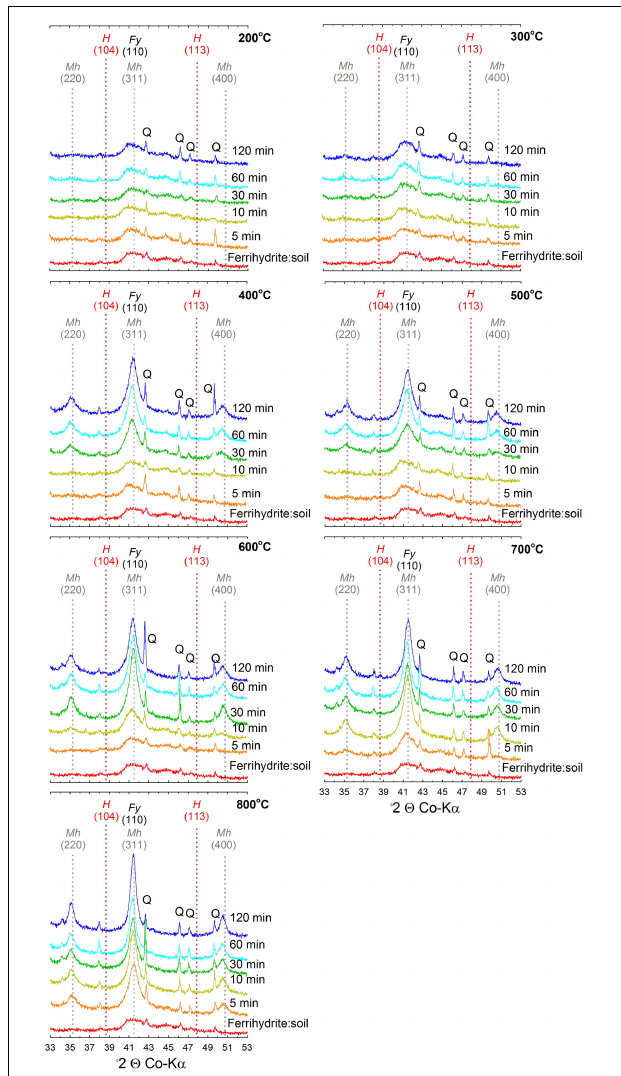
FIGURE 3 | X-ray diffractograms of ferrihydrite:soil mixtures after heating at 200, 300, 400, 500, 600, 700, and 800 ◦ C for 5, 10, 30, 60, and 120 min. Fy, ferrihydrite; Mh, maghemite; H, hematite; Q, quartz.